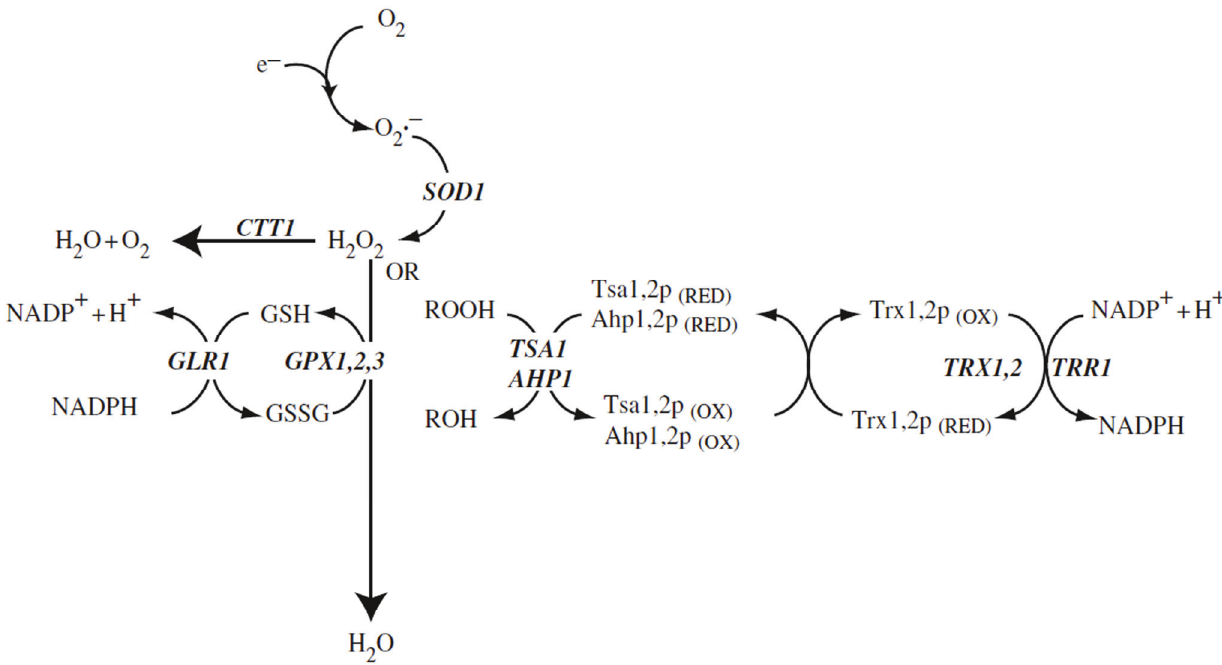
Figure 1. Reactive oxygen species and antioxidant defence systems in the cytosol. The main reactive oxygen species include the superoxide anion radical, hydrogen peroxide, and organic peroxides (ROOH) that are detoxified to water via the Cu, Zn-superoxide dismutase, catalase or glutathione systems. Hydrogen peroxide and organic peroxides (ROOH) can also be detoxified to an alcohol (ROH) by the thioredoxin system. Gene designations are the ones of S. cerevisiae . SOD1: Cu, Zn-superoxide dismutase; CTT1: catalase T; GSH: reduced form of glutathione; GSSG: disulfide form of glutathione; GPX1,2,3: the three glutathione peroxidases of S. cerevisiae ; GLR1: glutathione redutase; TSA1, AHP1: peroxiredoxins; TRX1,2: thioredoxins; TRR1: thioredoxin reductase (after Aung-Htut et al. 2012 [1]; with